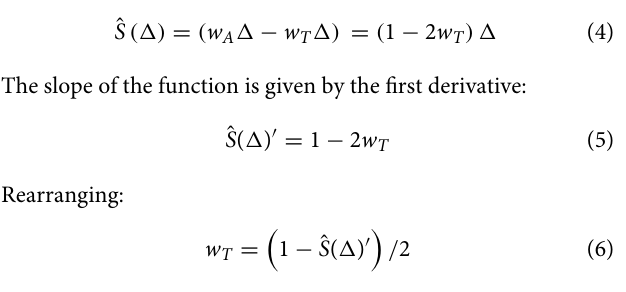
FIGURE 2 | Psychometric functions from one representative subject in the only-audio (A) and the only-tactile condition (B). The curves plot proportion of trials where the second stimulus was perceived more on the right for all its positions. Light green and light red curves represent subject’s performance for the non-attentional condition and dark green and dark red curves the performance for the attentional condition. Data